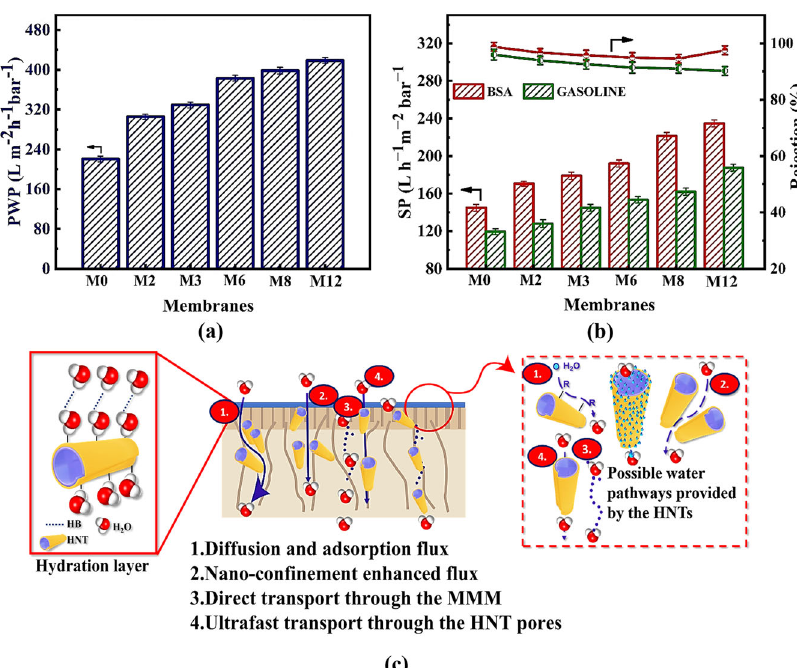
Fig. 8 Performance and proposed mechanism. Pure water permeance (PWP) ( a ) and solute permeance (SP) of the membranes for the treatment of BSA and oil-in-water emulsion (gasoline) ( b ), Proposed permeate fl ux channels of PSF/EVOH/HNTs MMMs ( c ). The rejection data for each solute represents the average of three runs and the error bars indicate the standard deviation of the data from three independent